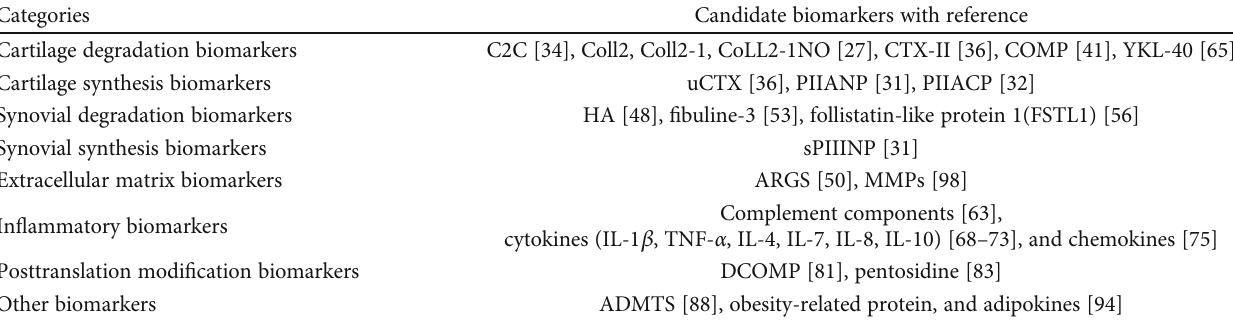
Table 1: The selected biomarkers of OA are classi fi ed according tissue involvement and metabolism.